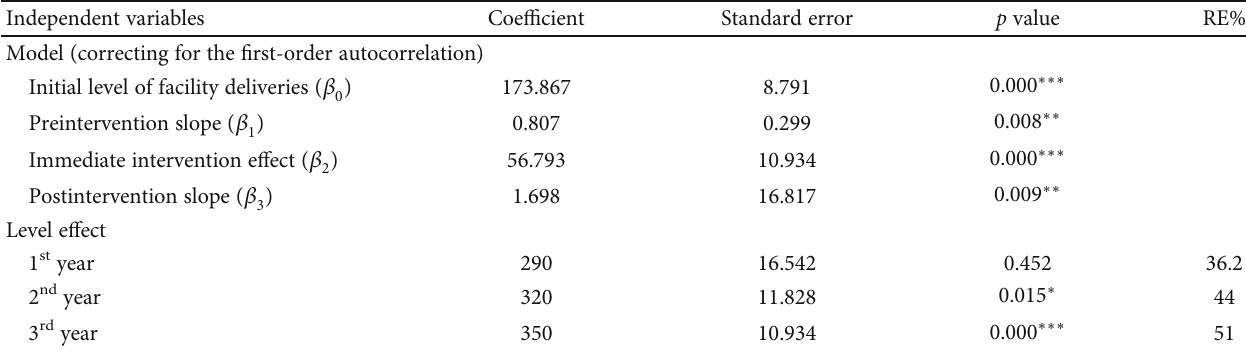
Figure 2: Trends for facility-based deliveries before and after implementation of the free maternity services policy in East Shewa zone (the line at 72 Table 2: Parameter estimates, standard errors, and p values of a segmented regression model predicting the average number of deliveries per month in East-Shewa zone, central Ethiopia, 2007-2016.